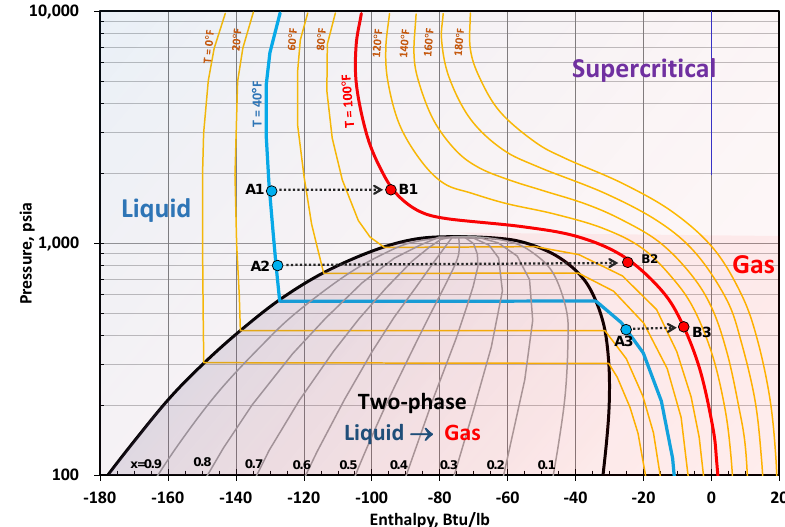
Figure 16. CO 2 pressure–enthalpy diagram showing the CO 2 phase state under different conditions. A1B1, A2B2, and A3B3 lines highlight the enthalpy needed to go from 40 ◦ F to 60 ◦ F.